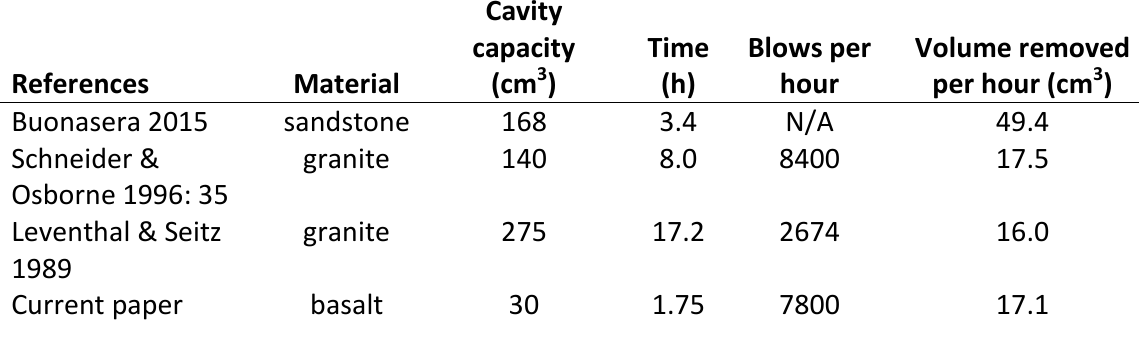
Table 2. Experimental studies replicating ground stone tools. Abbreviations: N/A - not